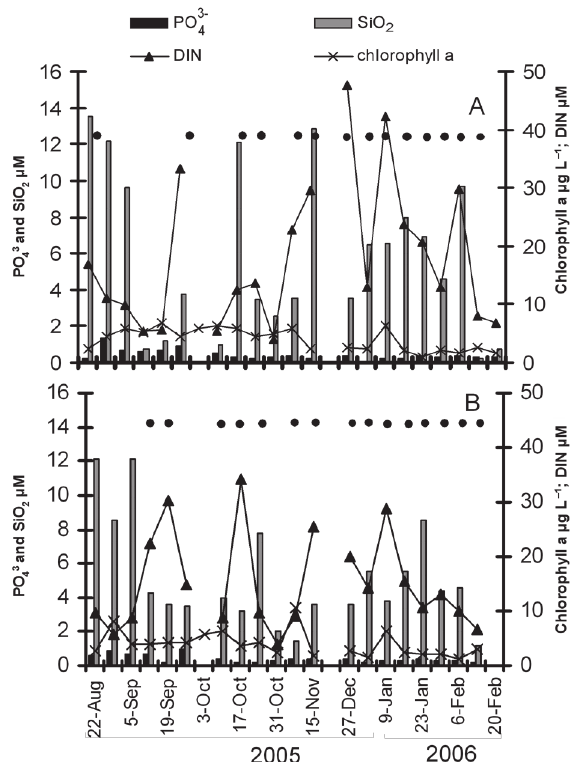
Fig . 4. – Weekly biological and chemical parameters in alfacs Bay at the surface (a) and bottom (B) as measured at a central station. chlorophyll a concentration (µg l –1 ) and dissolved inorganic ni- trogen (din, µM) are shown on one axis. dissolved inorganic p and Si (µM) on the other axis. probable inorganic p limitations are indicated in the graph as